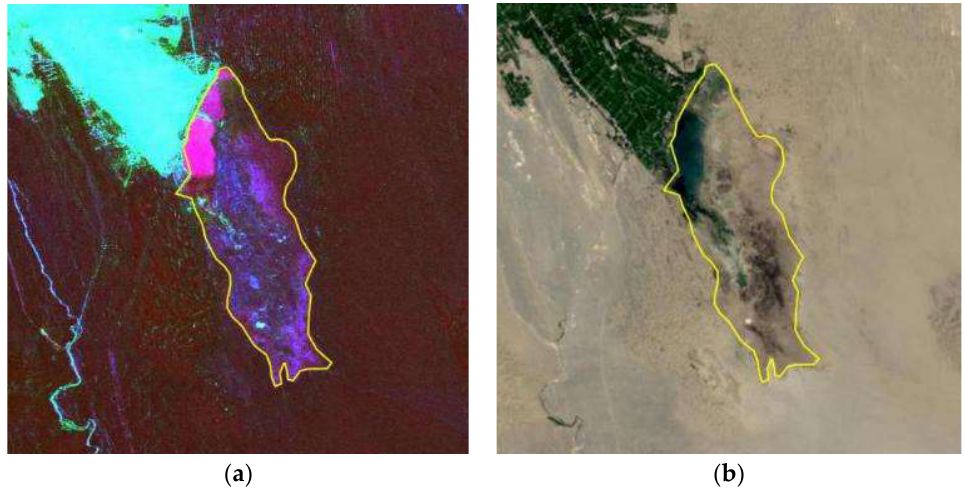
Figure 16. ( a ) New wetland area extracted using PALSAR-1 data. ( b ) New wetland area overlaid on the Landsat 8 OLI image.